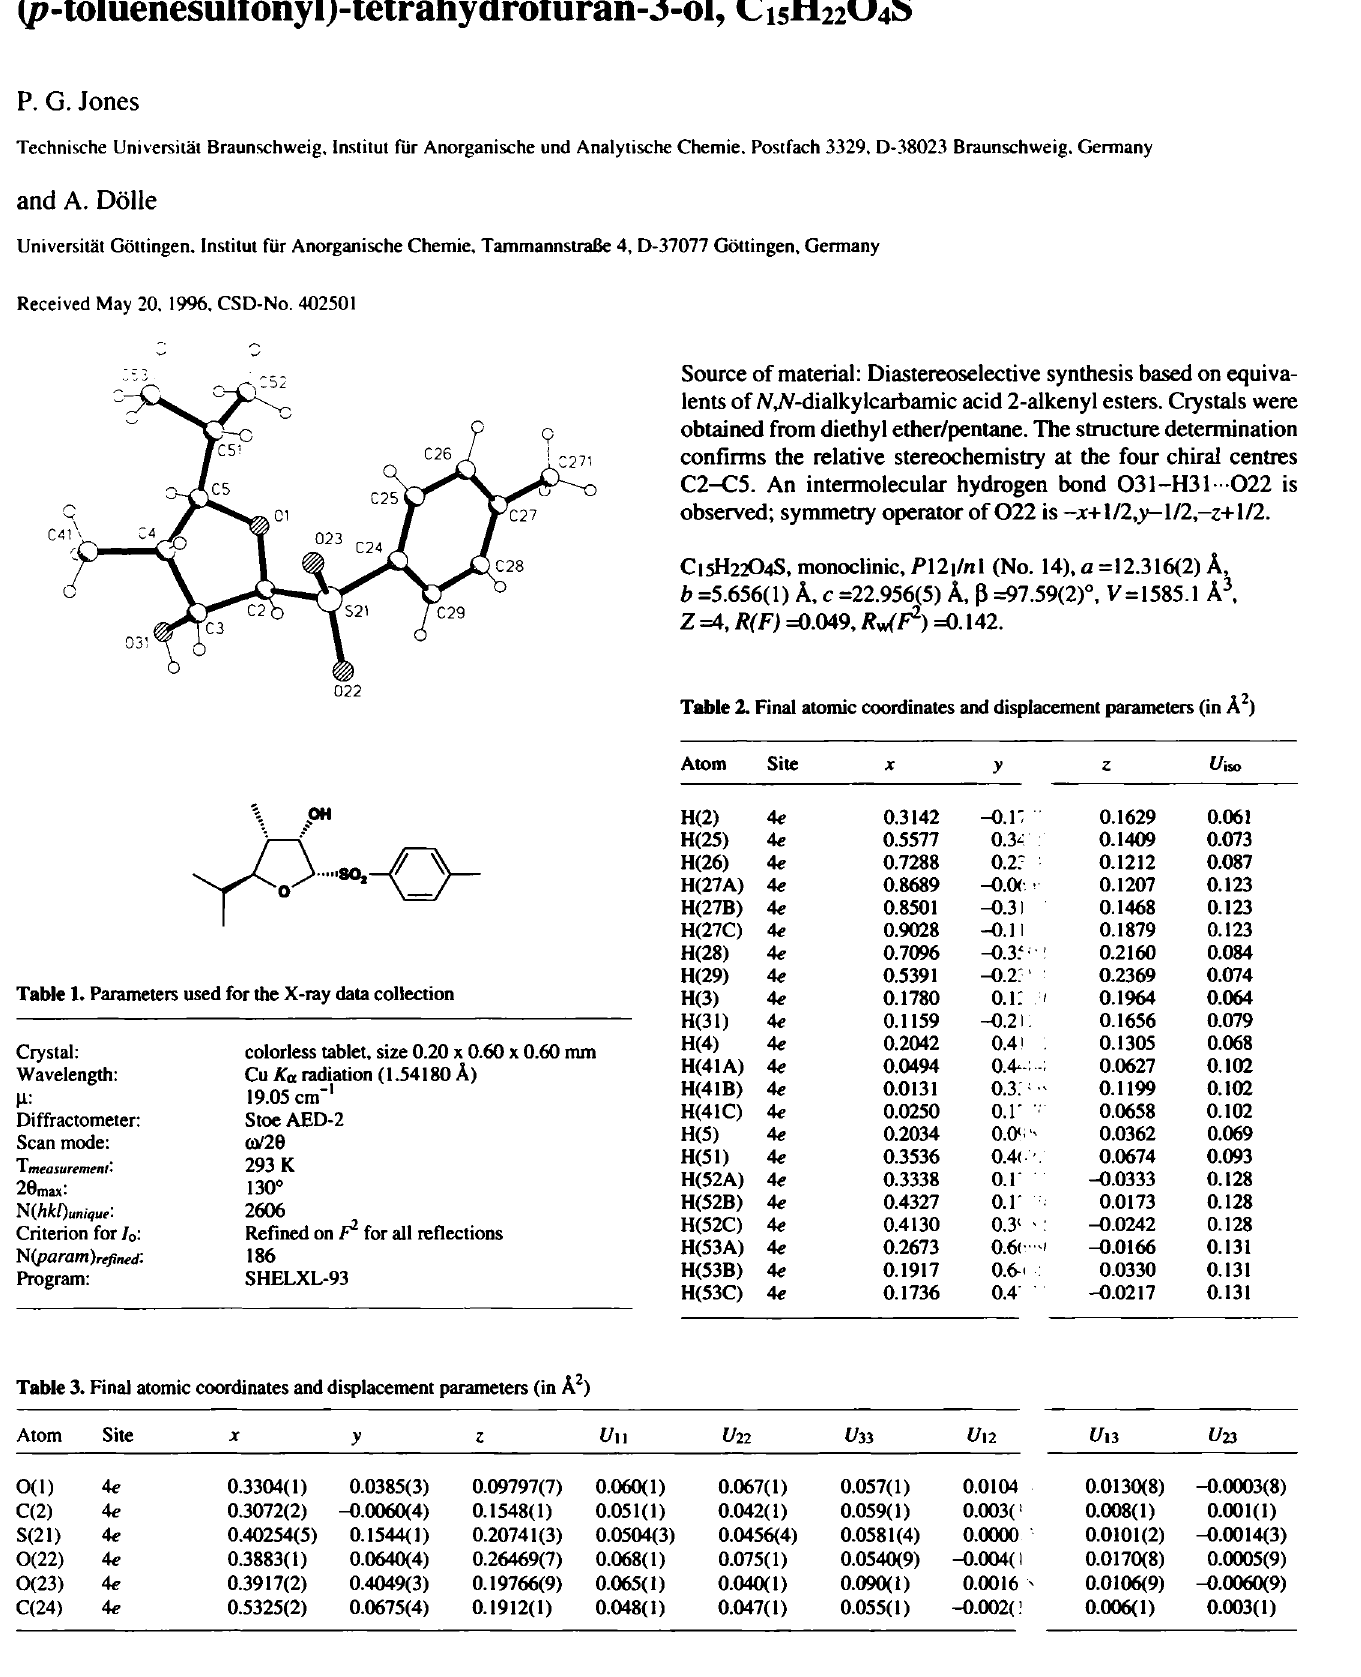
Table 1. Parameters used for the X-ray data collection Crystal: